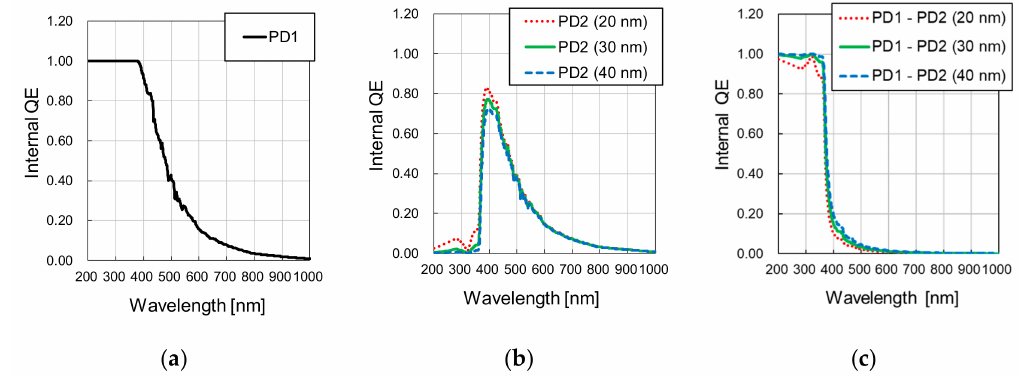
Figure 4. Calculated internal quantum e ffi ciency (QE) for ( a ) PD1, by assuming a first potential barrier at 0 nm depth and a second potential barrier at 460 nm depth, ( b ) PD2, for the conditions of first potential depth of 20 nm, 30 nm and 40 nm, with the second potential depth at 460 nm, and ( c ) PD1 – PD2, for each PD2